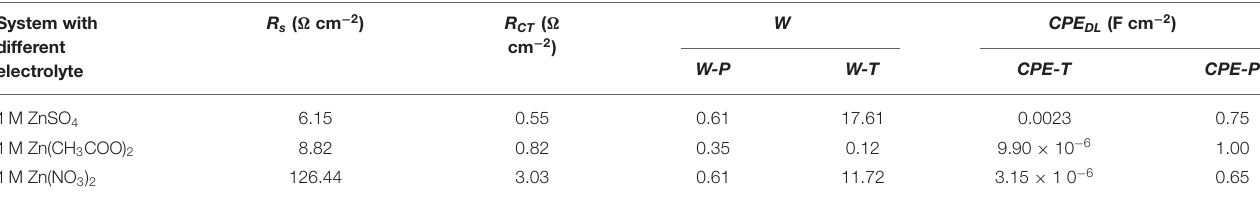
TABLE 1 | Fitting results list based on the equivalent circuit in Figure 2C . System with different